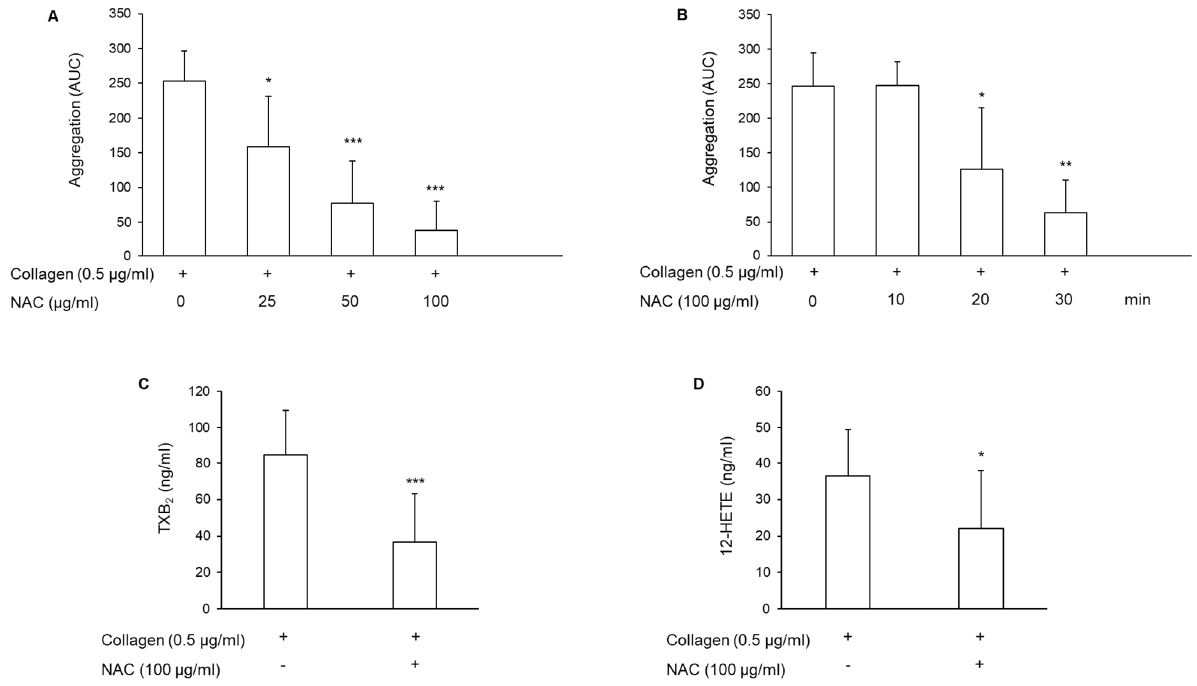
Figure 1. Effect of NAC on platelet aggregation and synthesis of arachidonic acid metabolites. PRP was incubated with NAC for 30 min at 37 °C, and subsequently, platelets were stimulated with collagen. ( A ) Concentration-dependent inhibition of aggregation induced by 0.5 μg/mL collagen after pre-treatment with NAC, n = 5. ( B ) Time-dependent inhibition of aggregation induced by collagen after pre-treatment with 100 μg/mL NAC, n = 4. ( C ) Levels of TxB 2 and ( D ) 12-HETE measured in PRP pre-treated with NAC and stimulated with collagen. n = 9; * p < 0.05, ** p < 0.01, *** p < 0.001 vs. collagen-stimulated PRP for ANOVA and Dunnett’s post hoc test ( A , B ) and for Student t -test ( C , D ).